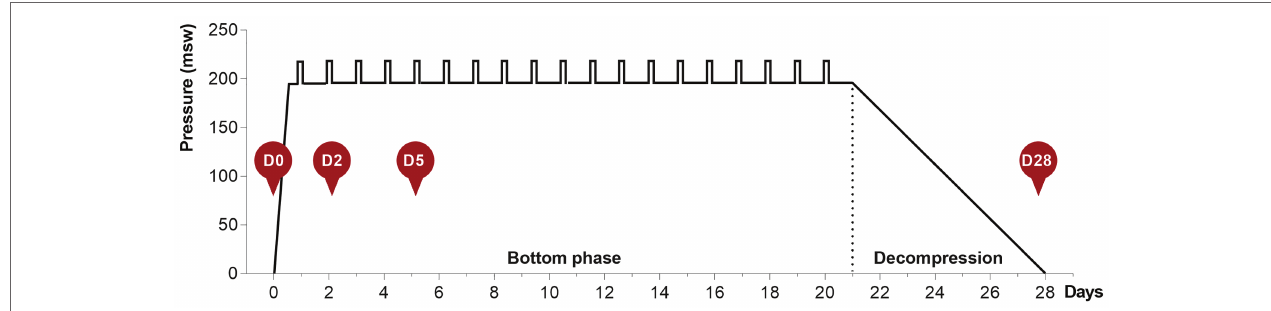
FIGURE 1 | The 28-day heliox saturation profile. Hyperbaric saturation was done in a heliox atmosphere with 6 h compression, 21-day bottom phase, and 7-day decompression. Daily underwater work excursions (bell-runs) in the bottom phase are indicated by vertical bars. Saliva collection time-points are shown as red circles: D0, before saturation; D2 and D5, days 2 and 5 of the bottom phase; D28, after